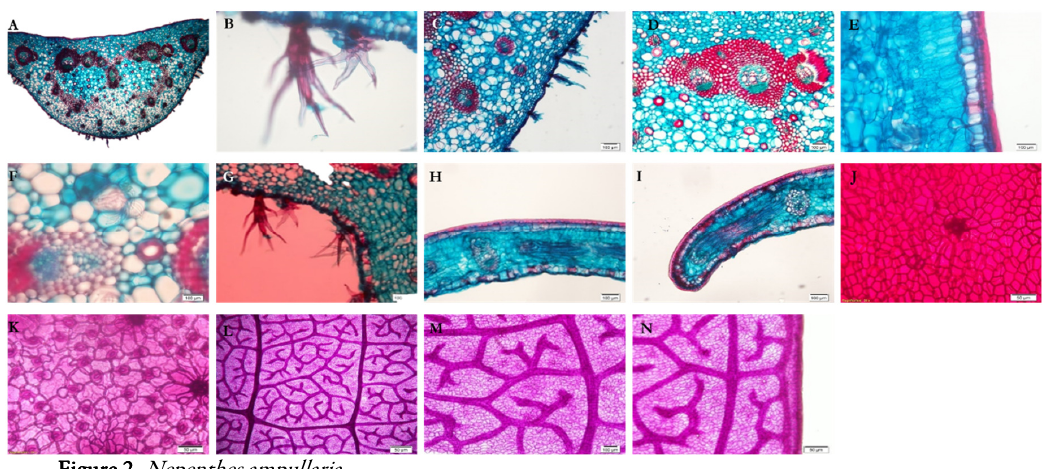
Figure 2. Nepenthes ampullaria (A) Midrib TS. (B) Close up of multicellular trichomes. (C) Multicellular trichomes. (D) Vascular bundle. (E) Hypodermis. (F) Solitary crystals. (G) Multicellular trichomes on the midrib adaxial surface. (H) Lamina TS. (I) Margin TS. (J) Adaxial epidermis. (K) Abaxial epidermis with stomata observation. (L) Lamina venation. (M)